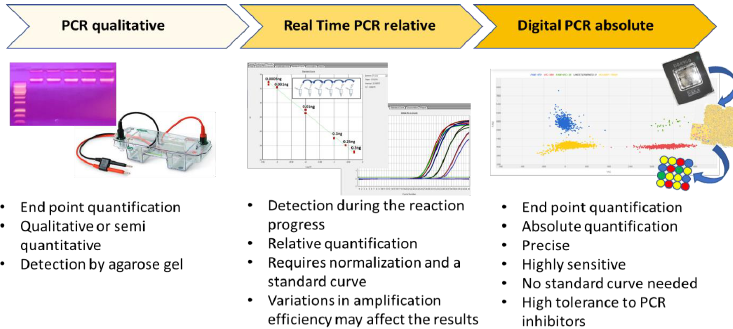
Figure 1. The three main PCR technologies are reported, and their main features are schematically